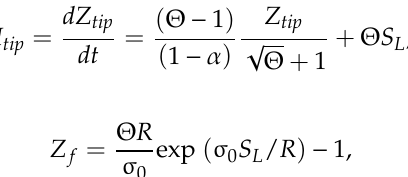
various Θ = 6, 8,10 ( b ). various Θ = 6, 8, 10 ( b